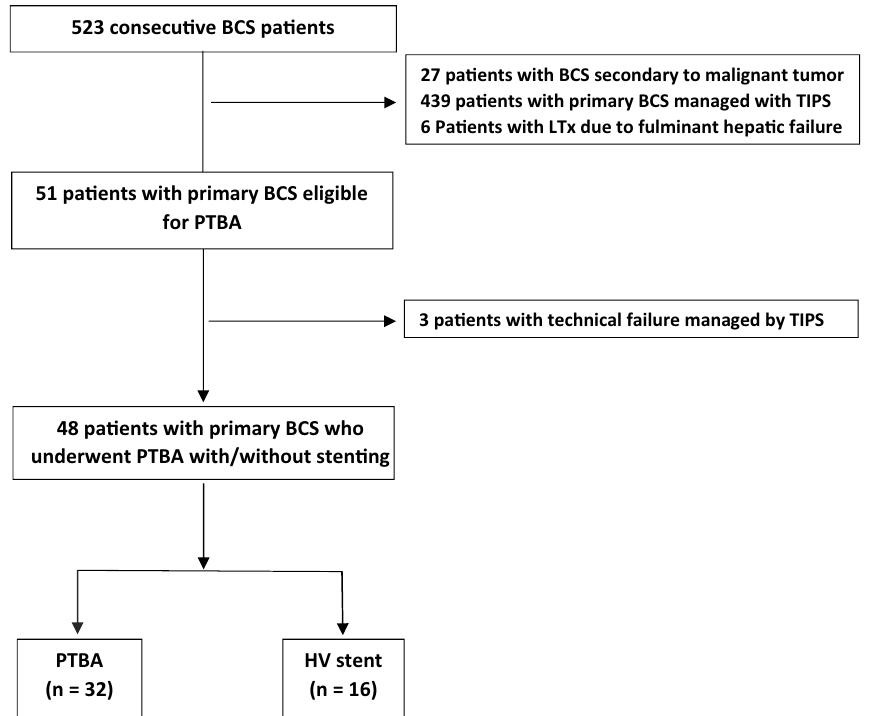
Figure 4. Flow chart of inclusion and exclusion of BCS patients. BSC, Budd Chiari syndrome; TIPS, transjugular intrahepatic portosystemic shunt; LTx, liver transplantation; HV, hepatic vein; PTBA, percutaneous transluminal balloon